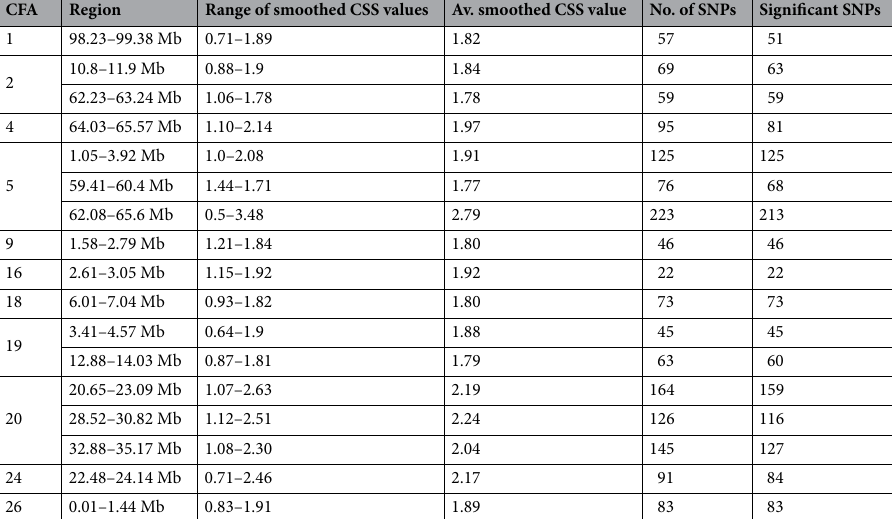
Table 4. Selected genomic regions in Mountain hounds used for